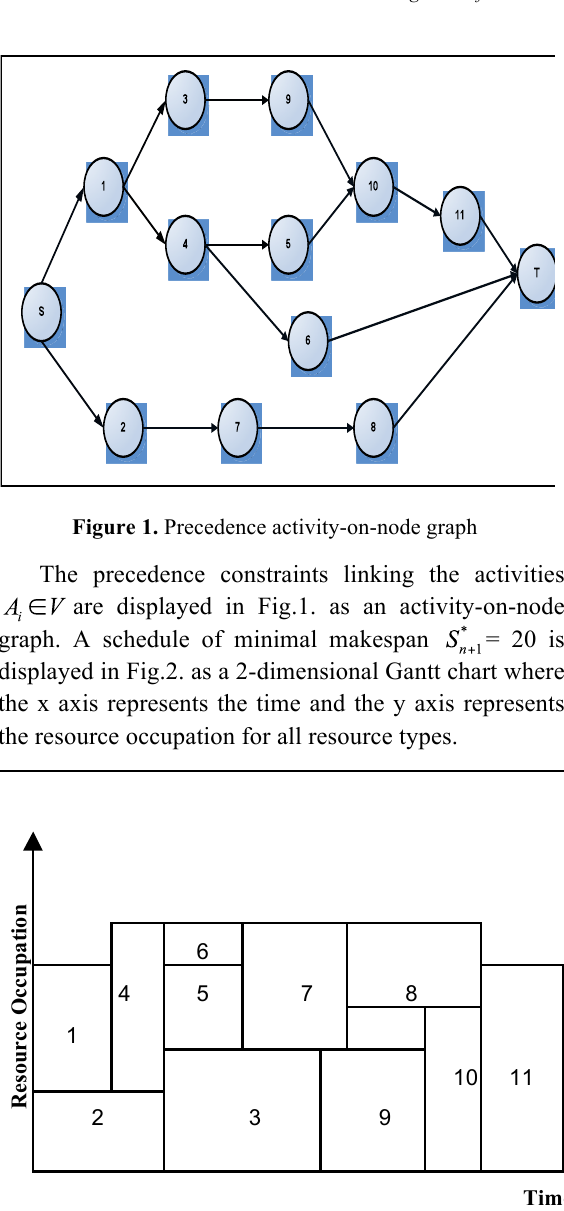
Figure 2. Schedule of minimal makespan for the resource